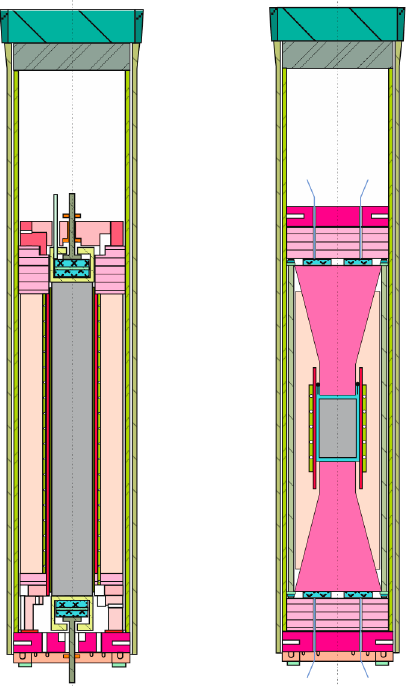
Figure 10. Scheme of the 2.5 GPa gas pressure vessel.